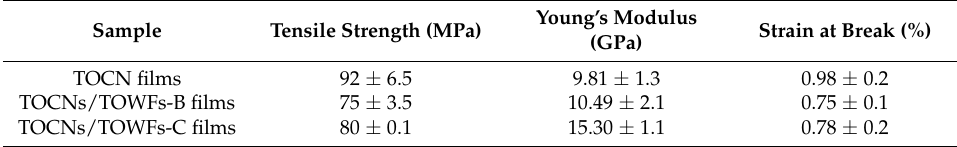
Table 3. Tensile properties of the polyethylene terephthalate (PET) films, TOCN films, TOCNs/TOWFs-B films, and TOCNs/TOWFs-C